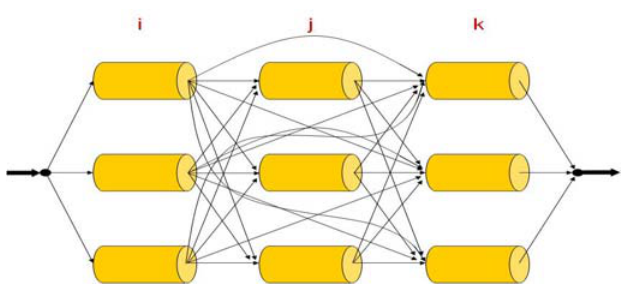
Figure 2. Superstructure overview.